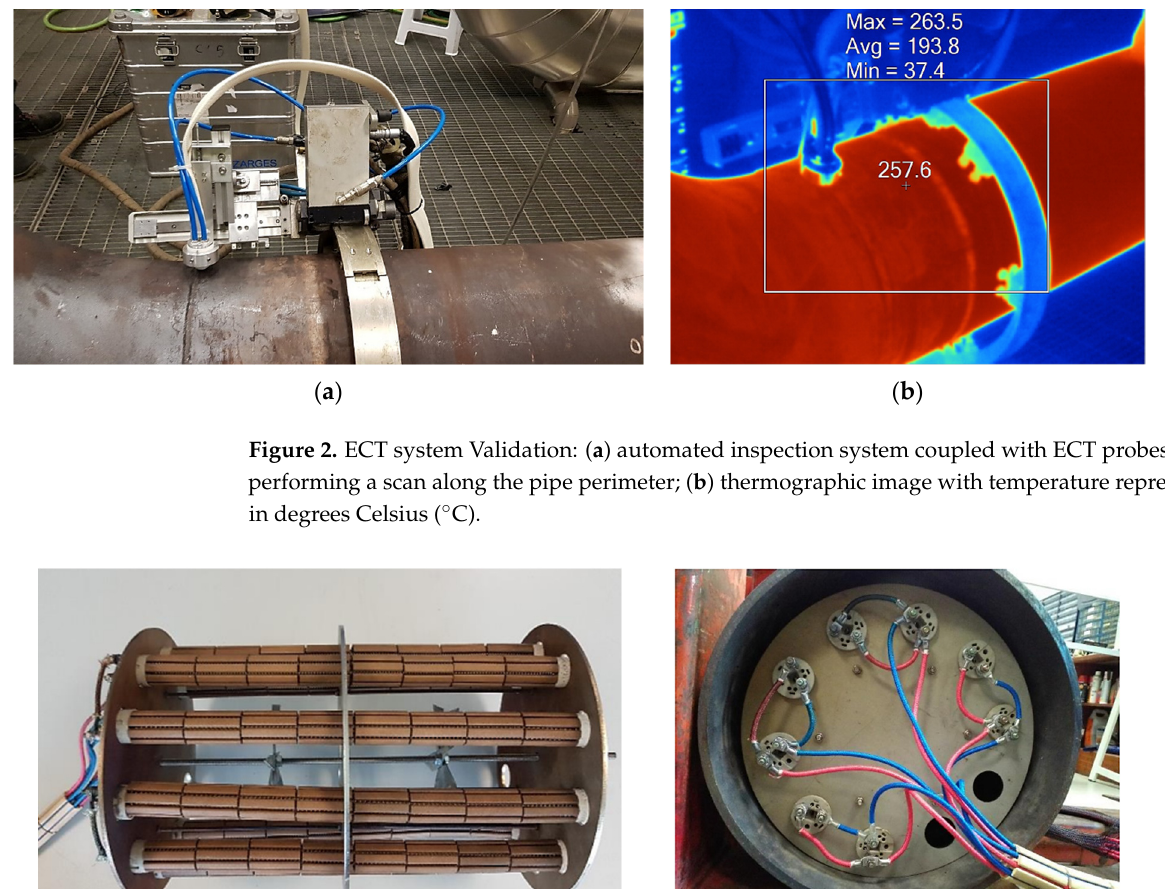
Figure 3. ( a ) Heating system assembly and ( b ) electrical wires for the